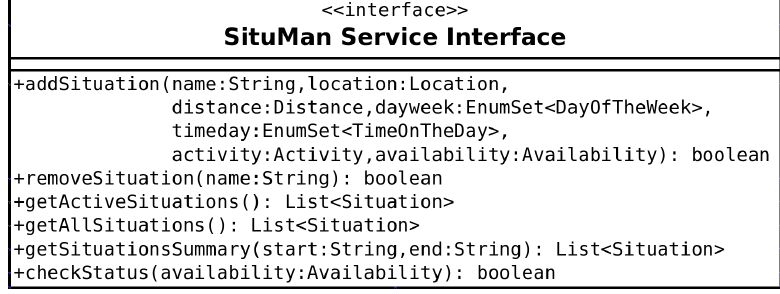
Figure 4. SituMan service interface.